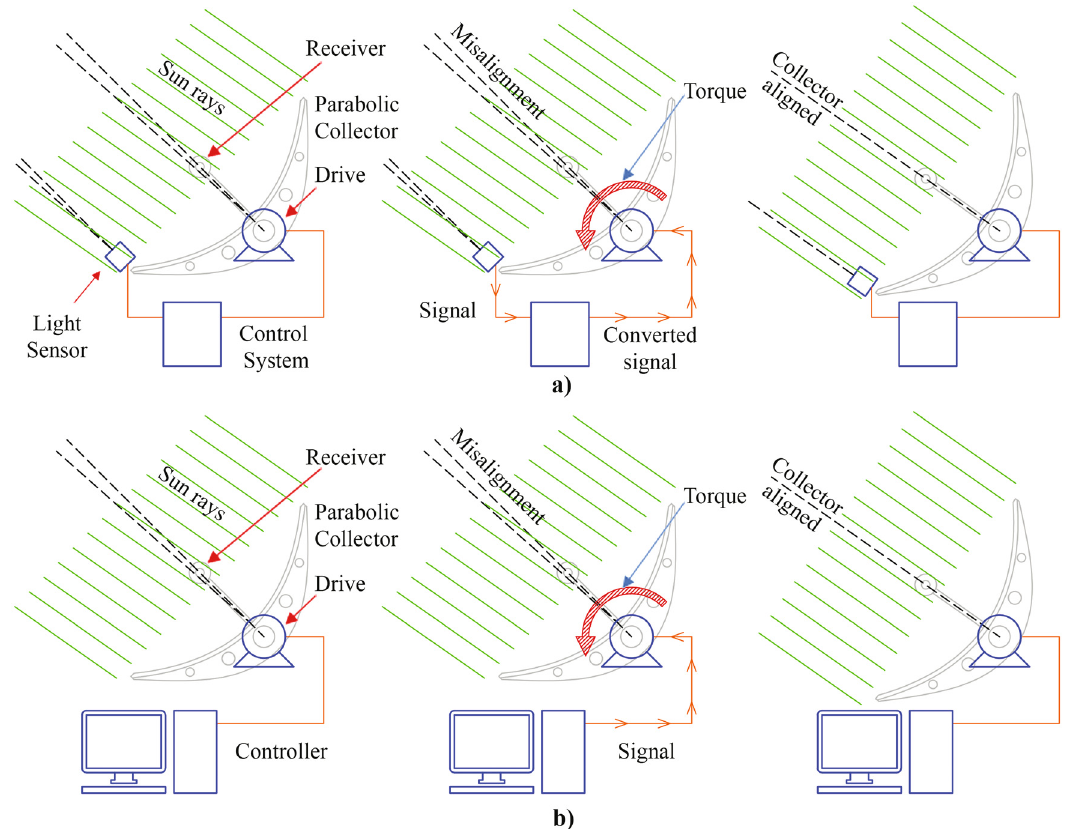
Figure 8: Solar tracker types: ( a ) active closed - loop, ( b ) active open -